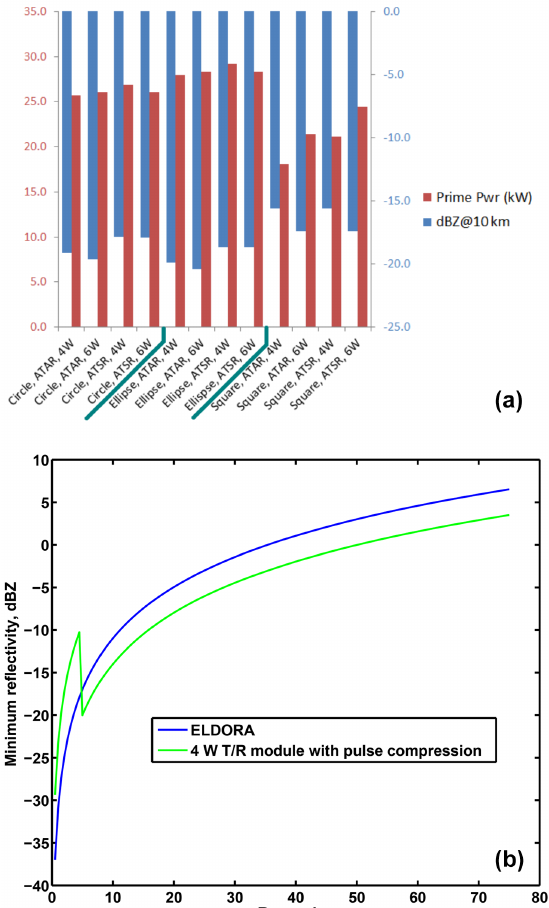
Figure 8. (a) Sensitivity comparison for three apertures, using two T/R module architectures (ATAR, ATSR) and two different HPAs (4, 6W). (b) Sensitivity of APAR as a function of